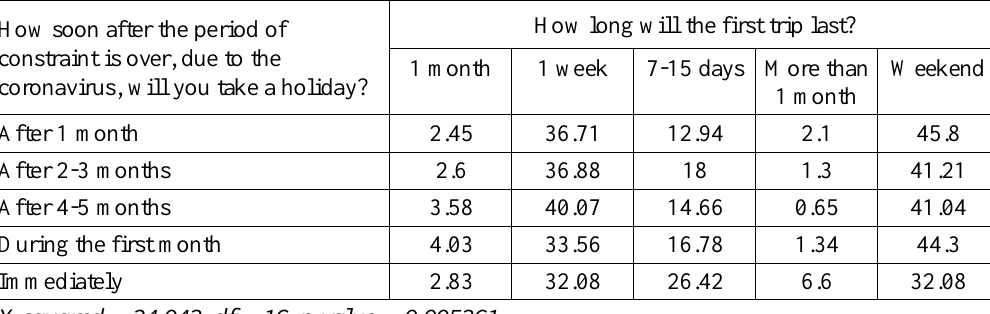
During the first month